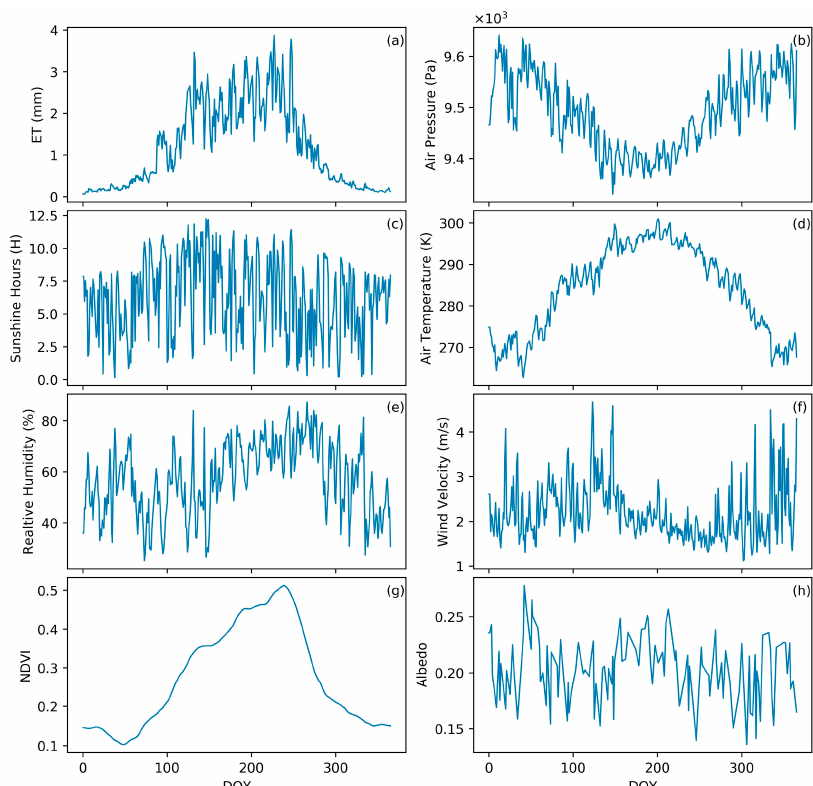
Figure 8. The trends in diurnal average ET ( a ) and parameters ( b – h ) in 2014, where ( b ) is the trend of air pressure; ( c ) is sunshine hours (Sunt); ( d ) is the average air temperature (Tavg) estimated based on the average of the maximum and minimum; ( e ) is the relative humidity (Humd); ( f ) is wind speed (Winv); ( g ) is the NDVI and ( h ) is Albedo.